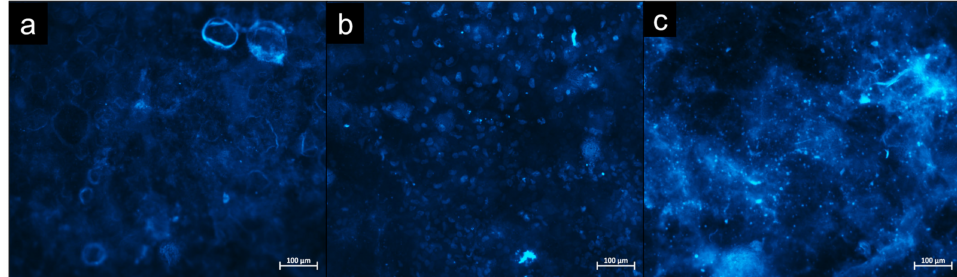
Figure 8. DAPI staining analysis of U-2 OS cells seeded on ( a ) PEI, ( b ) PDDA and ( c ) CHI coatings cultured under standard conditions for 7